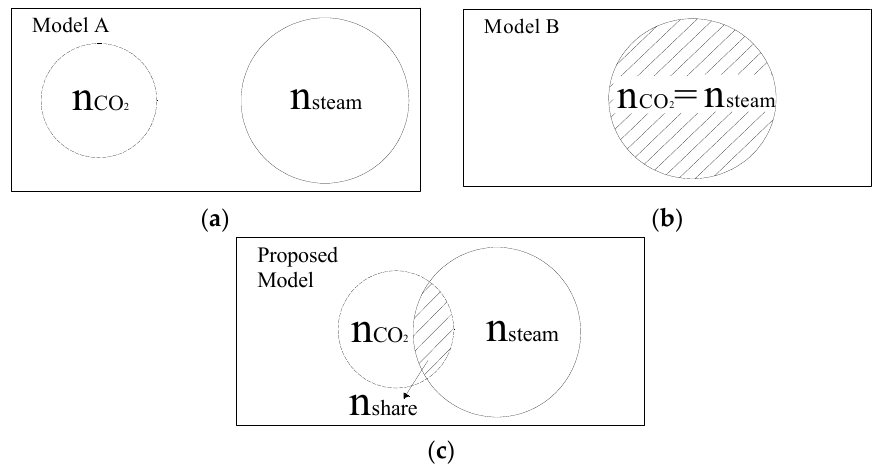
Figure 2. Models of char–CO 2 –steam gasification: ( a ) Model A; ( b ) Model B; ( c ) Modified model.